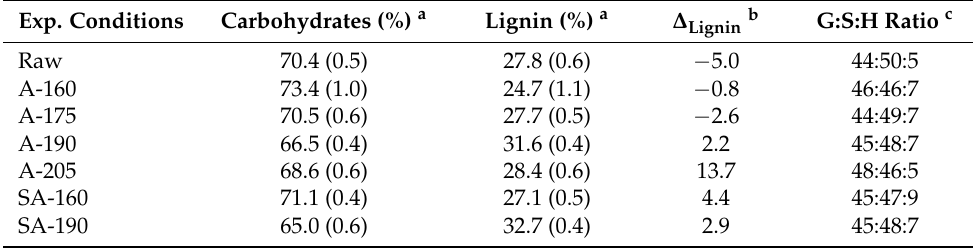
Table 2. Pyrolysis-gas chromatography/mass spectrometry (Py-GC/MS) analysis of raw wheat straw and pretreated solids. Exp.